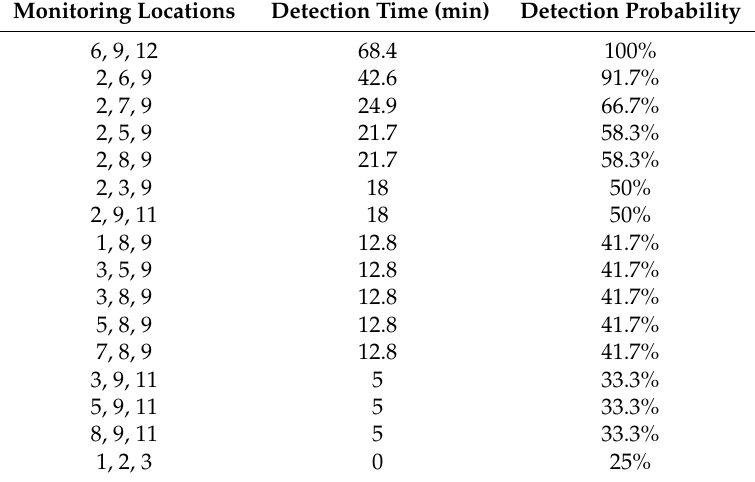
Table 6. Pollution detection time and pollution detection probability in Pareto frontier with a detection threshold of 1